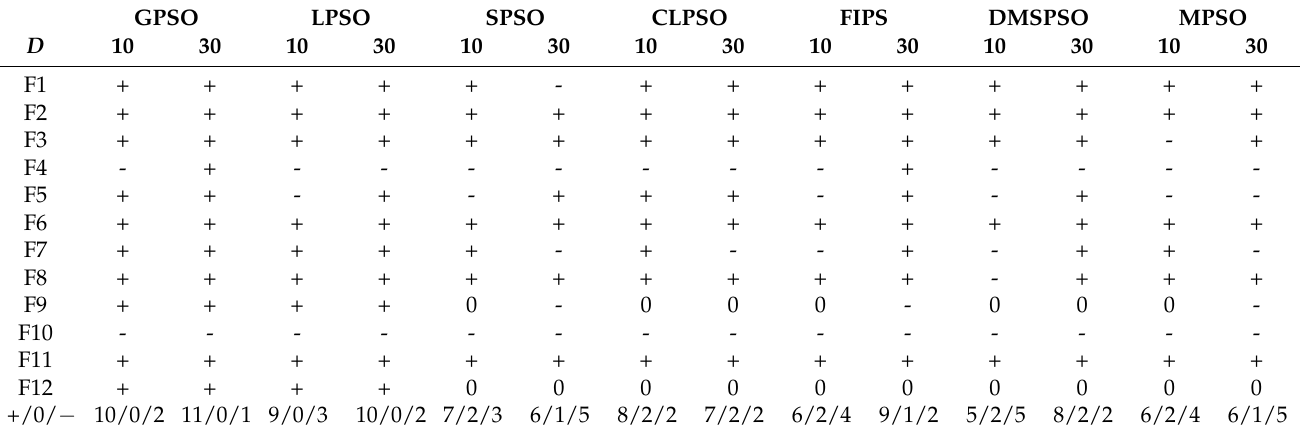
Table 8. Statistical analysis of Wilcoxon signed-rank test between PSO-ED and other PSO